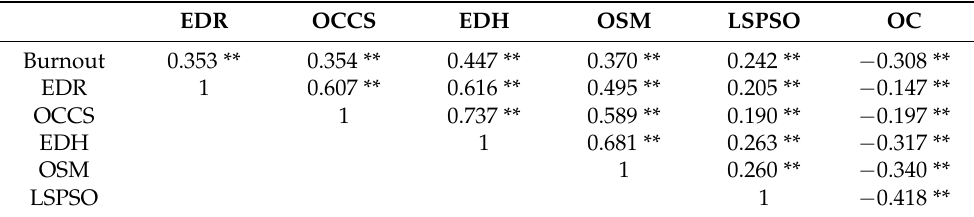
Table 4. Correlation coefficients among burnout, five sub-scales of emotional labor, and organiza- tional climate. EDR OCCS EDH OSM LSPSO OC Burnout 0.353 ** 0.354 ** 0.447 ** 0.370 ** EDR 0.607 **